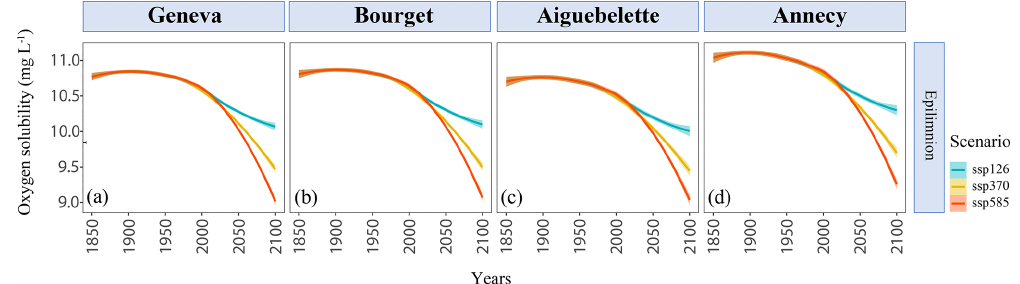
Figure 9. Annual averages of potential oxygen solubility over the period 1850–2100, in the epilimnion calculated from MyLake daily water temperature simulations for three different climate scenarios (SSP126, SSP370, SSP585) in lakes Geneva (a) , Bourget (b) , Aiguebelette (c) , and Annecy (d)